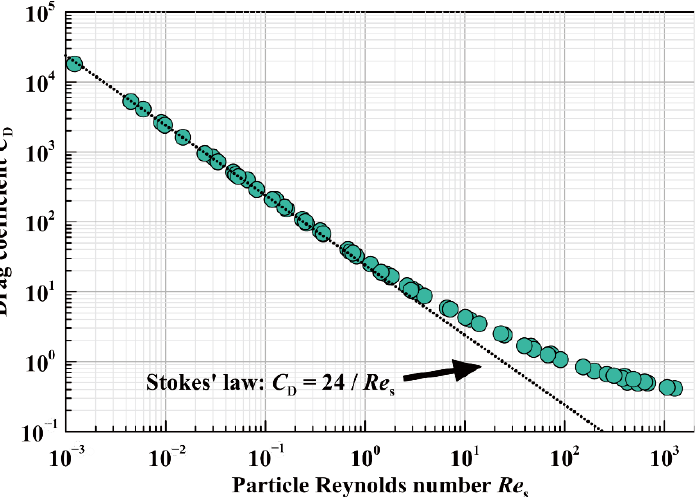
Figure 8. C D – Re s relationship obtained by 67 tests of sphere settlement experiments. The form of fitting formula refers to the existing classic expression ‘ form of drag co- efficient ’ and carries out parameter fitting for 67 tests of experimental points. It is found that the expression form of the drag coefficient proposed by Cheng has the best goodness of fit, and its expression is: